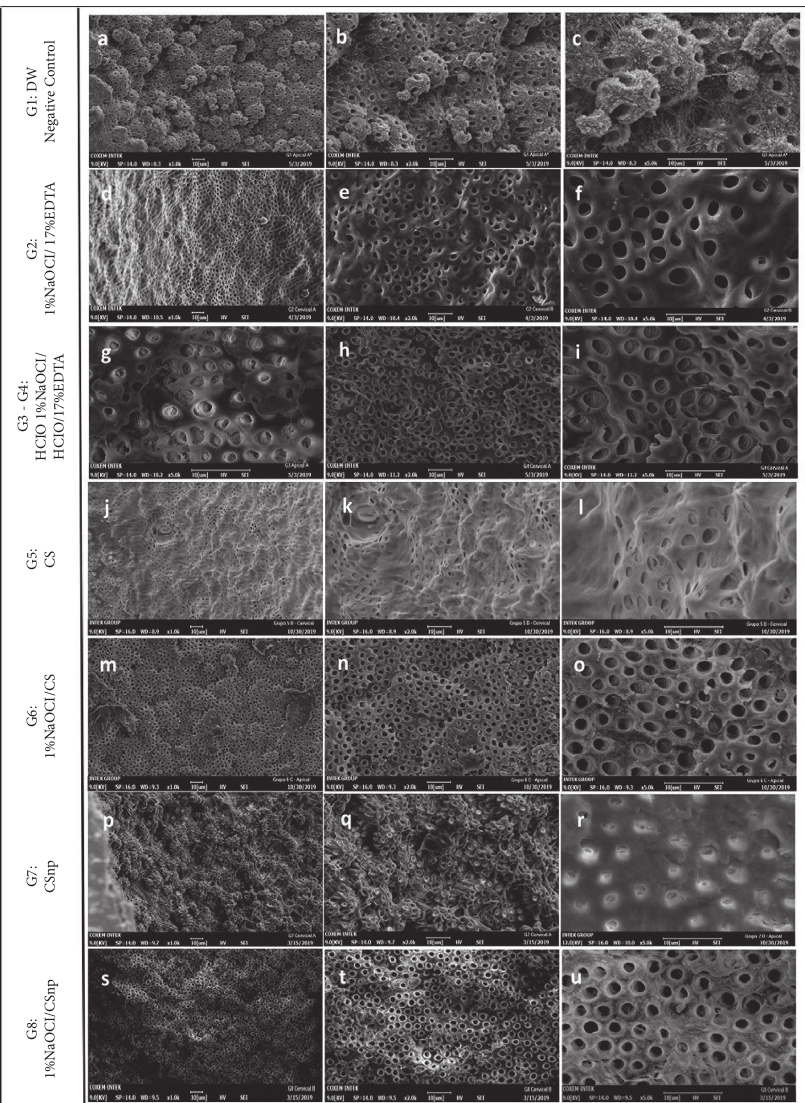
Figure 3: Representative SEM photographs from the cervical and apical thirds, at 1.000 × , 2.000 × , or 5000 × , of each group: visible dentinal tubules were seen in the samples treated with 1% NaOCl+17% EDTA; 1% NaOCl+0.025% HOCl+17% EDTA; 1% NaOCl+0.2%CS; and 1% NaOCl+ CSnp. Greater tubular diameter is seen in f, i, and o. Greater number of tubules per field is seen in h, n, and t. Intertubular dentin appearance is seen in l, o, r, and